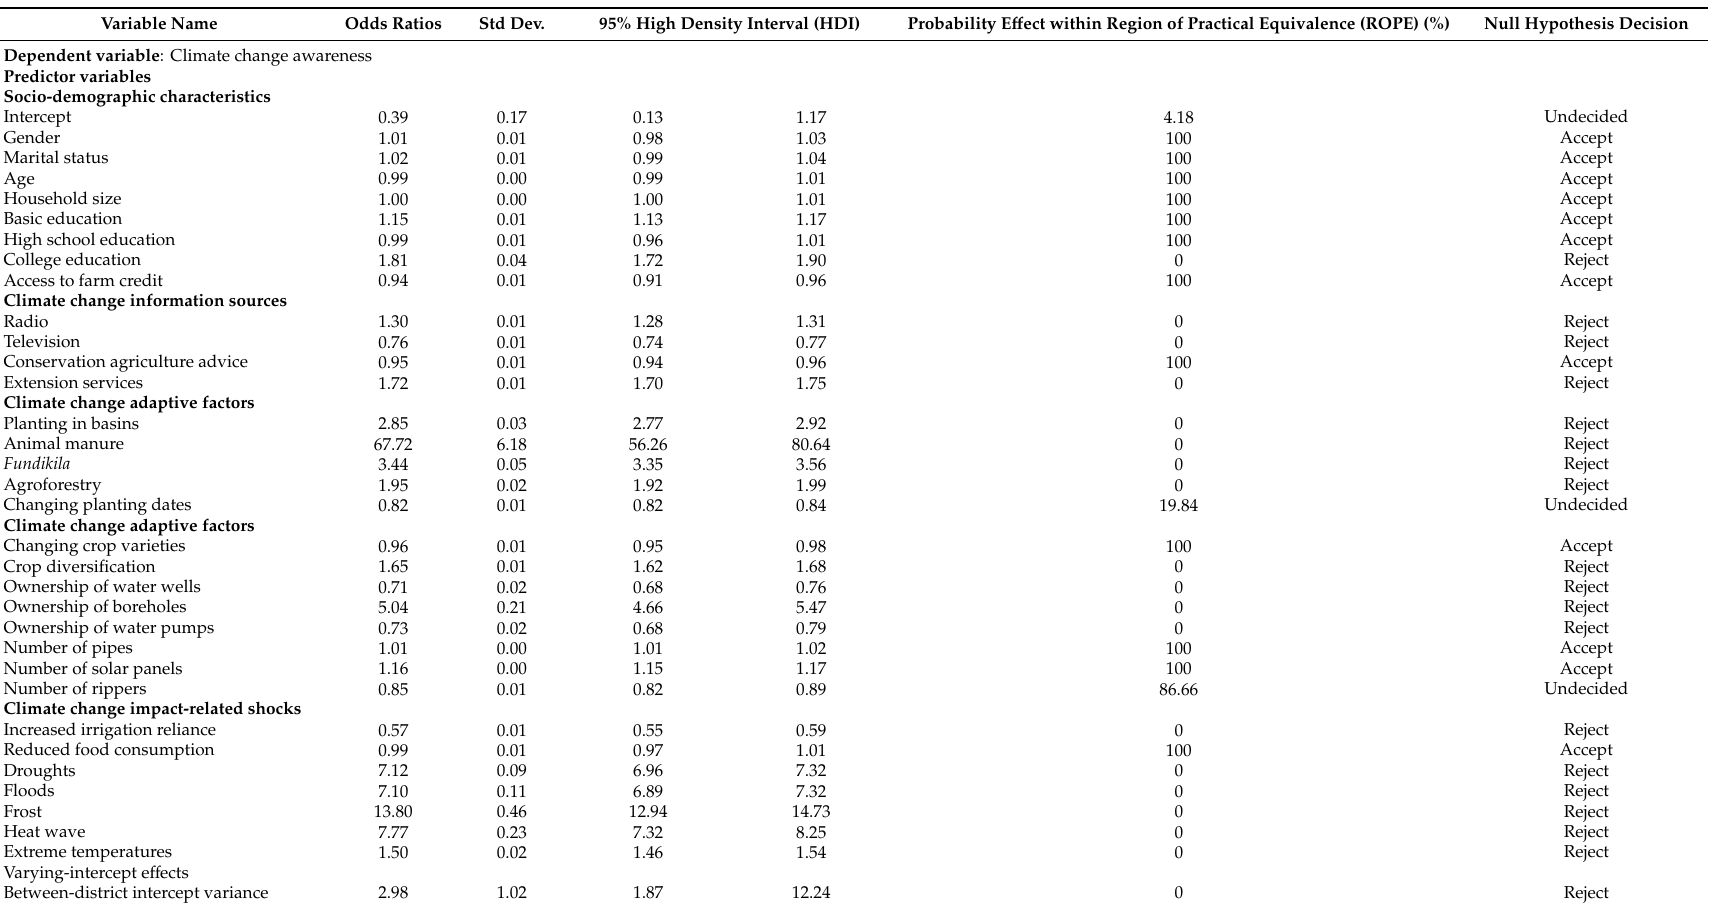
Table 2. Odds ratios, standard deviations, 95% highest density intervals, probability e ff ects and null hypothesis decision